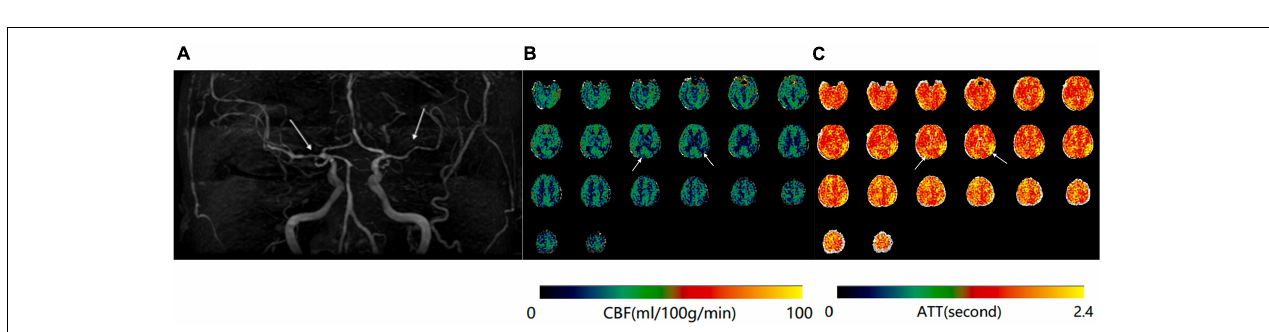
FIGURE 1 | Normal magnetic resonance angiography (MRA) (A) , mean cerebral blood flow (mCBF) (B) , and arterial transit time (ATT) (C) maps of a 65-year-old woman in the control group.